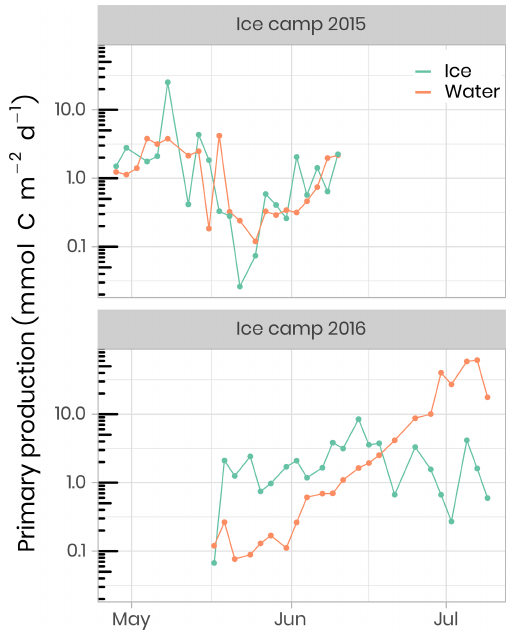
Figure 11. Temporal evolution of primary production in ice and water (depth-integrated) for both ice camp missions.